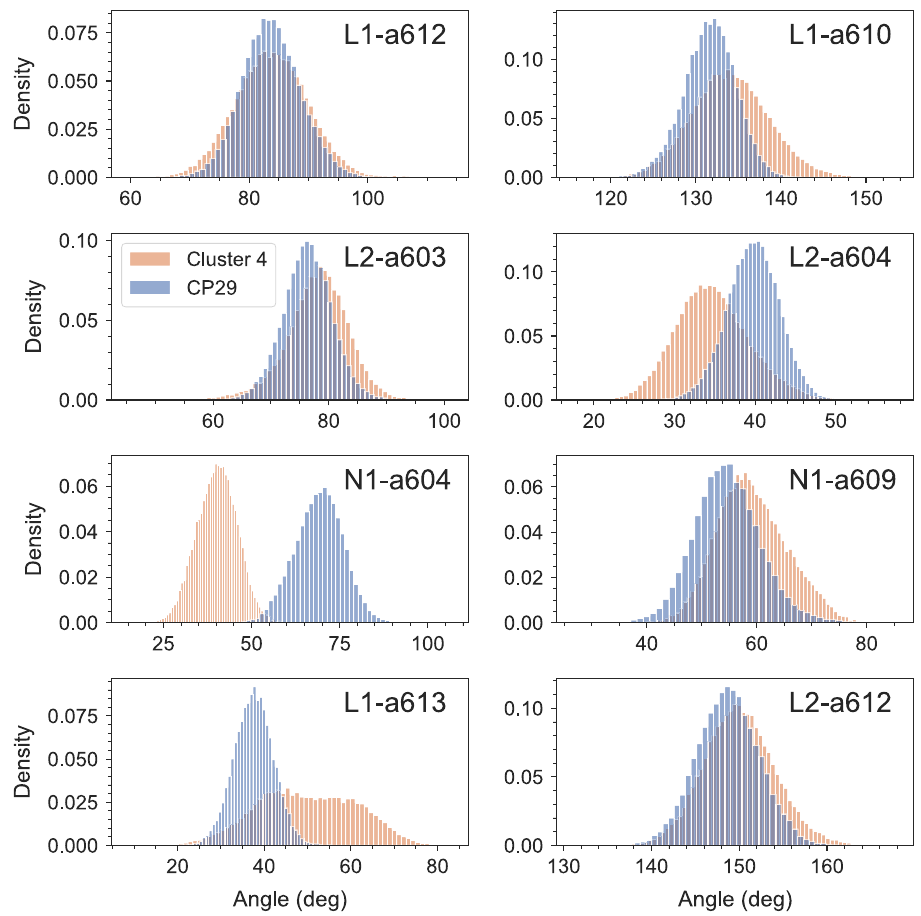
Fig. 4 Mutual orientation of Cars and Chls. The orientation is de fi ned as the angle between Chl NB → ND vector and Car C15 → C6 vector corresponding to the orientation of the Chl Q y transition and Car S 2 transition, respectively. The analysis was performed on 40,000 con fi gurations extracted every 50 ps of the MD simulation for LHCSR1 (orange distribution) and on 30,000 con fi gurations with the same time-step for CP29